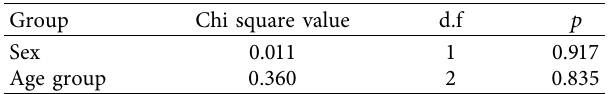
Table 2: The significance of the age group and gender match in the